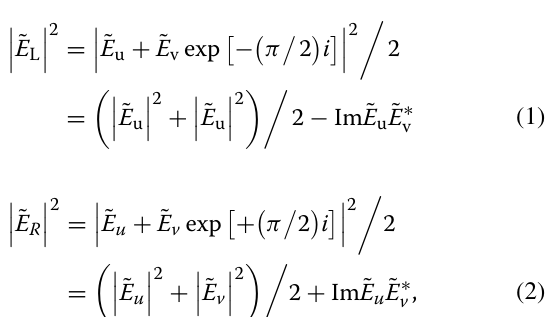
where * indicates a complex conjugate and Im indicates an imaginary part. 〈 〉 denotes the ensemble average of eight raw spectra obtained during one spin period. A frequency table of downlinked spectrum data is shown in Table 2. The downlinked spectrum data below 1 MHz and above 1 MHz are generated from 2.5 and 25 MSPS raw spectrum data, respectively. In order to reduce the data output rate, averaging among the intensities of raw spectra at neighboring frequency steps is also performed.